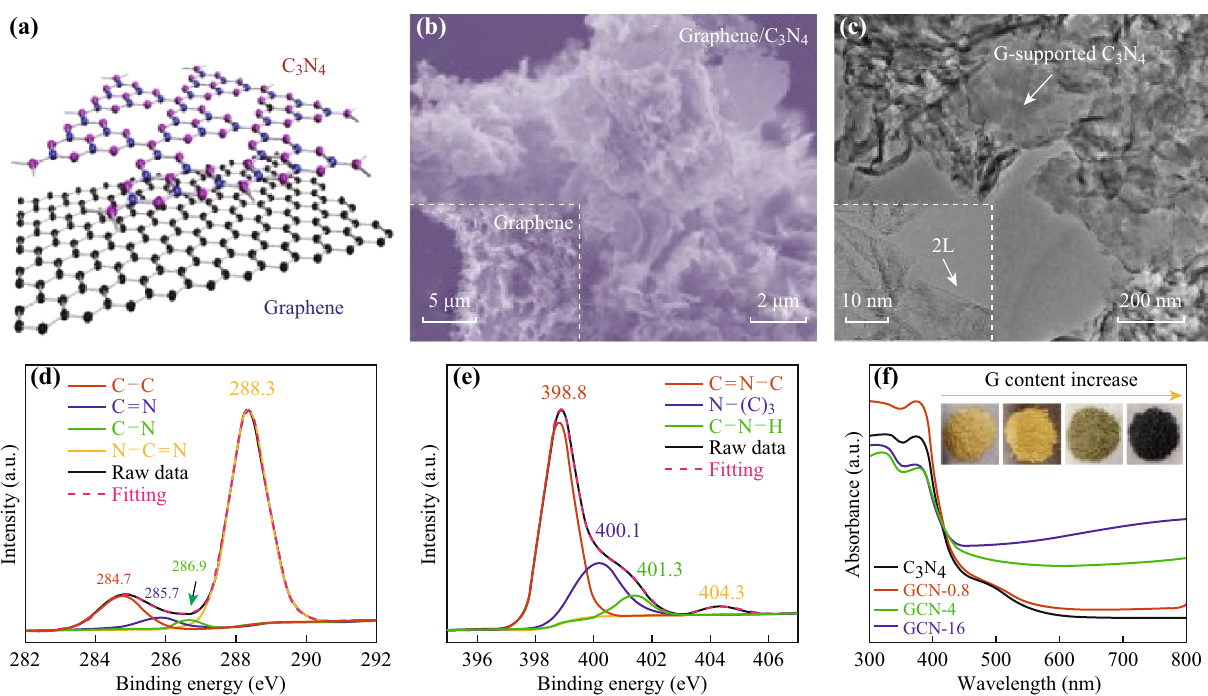
Fig. 3 a Schematic 3D g-C 3 N 4 /Graphene structures. b, c SEM images of g-C 3 N 4 /graphene nanocomposites. Inset TEM image. d C 1 s , e N 1 s XPS and f UV–vis spectra of g-C 3 N 4 /graphene nanocomposites. Insets : photographs of the powder samples. Reprinted with permission